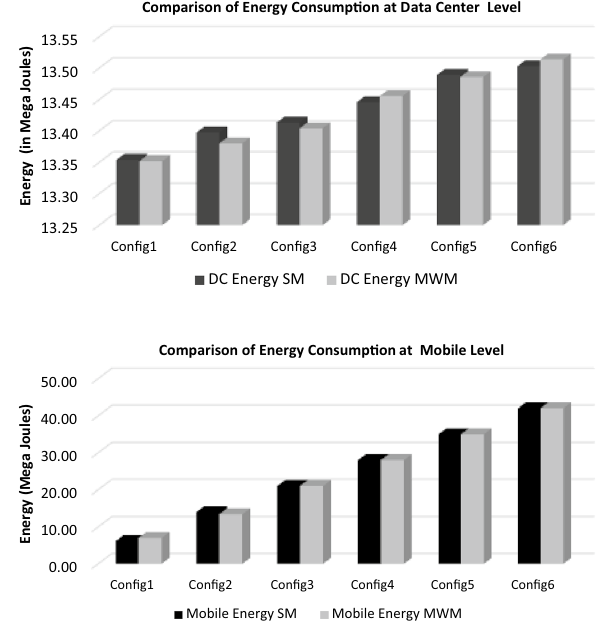
Comparison of Energy Consump(cid:31)on at Mobile